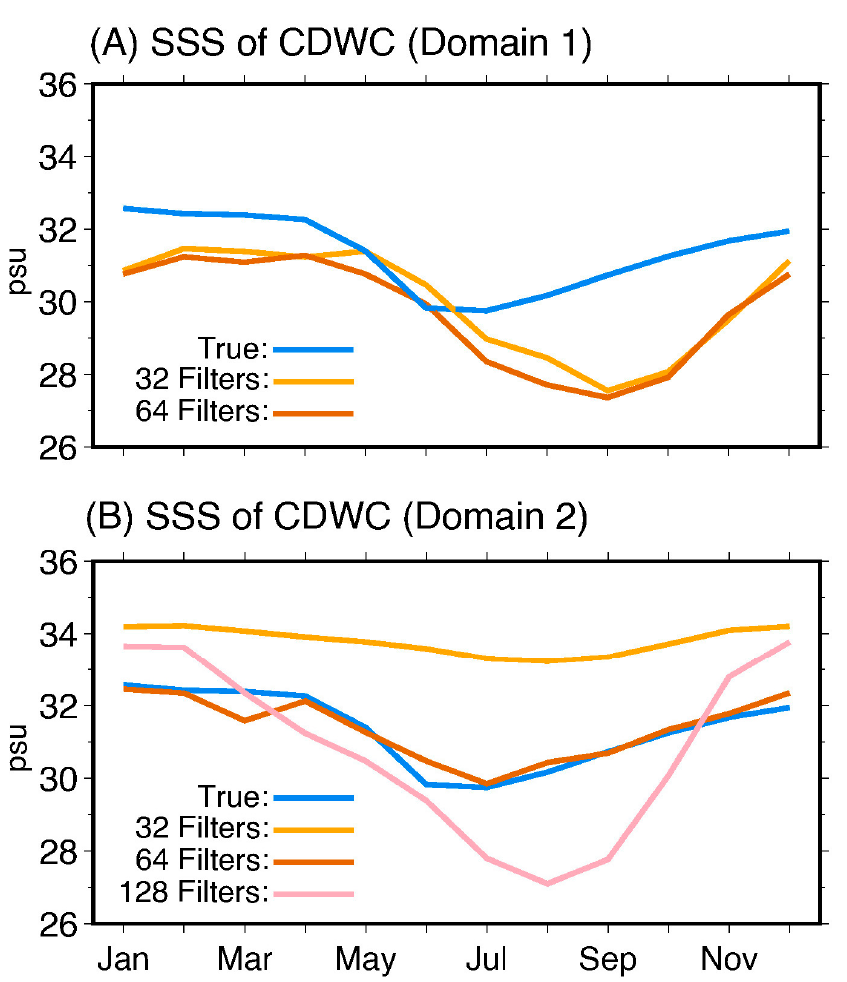
Figure 9. Comparison of the true and predicted SSSs in the CDWC region using the ( A ) Domain 1 and ( B ) Domain 2 models with di ff erent fi lters.